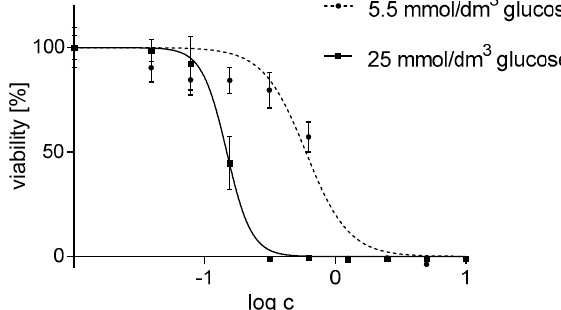
Figure 1 . The effect of hydrogen peroxide on the survival of Hep G2 cells (1 × 10 3 cells per well). The cells were cultured in a medium with two variants of glucose concentration: 5.5 mmol/dm 3 and 25 mmol/dm 3 for 24 h, treated with H 2 O 2 for 10 min, the measurements were taken after another 24 h. IC 50 parameters were compared with Student’s t-test, n = 6, α = 0.05.